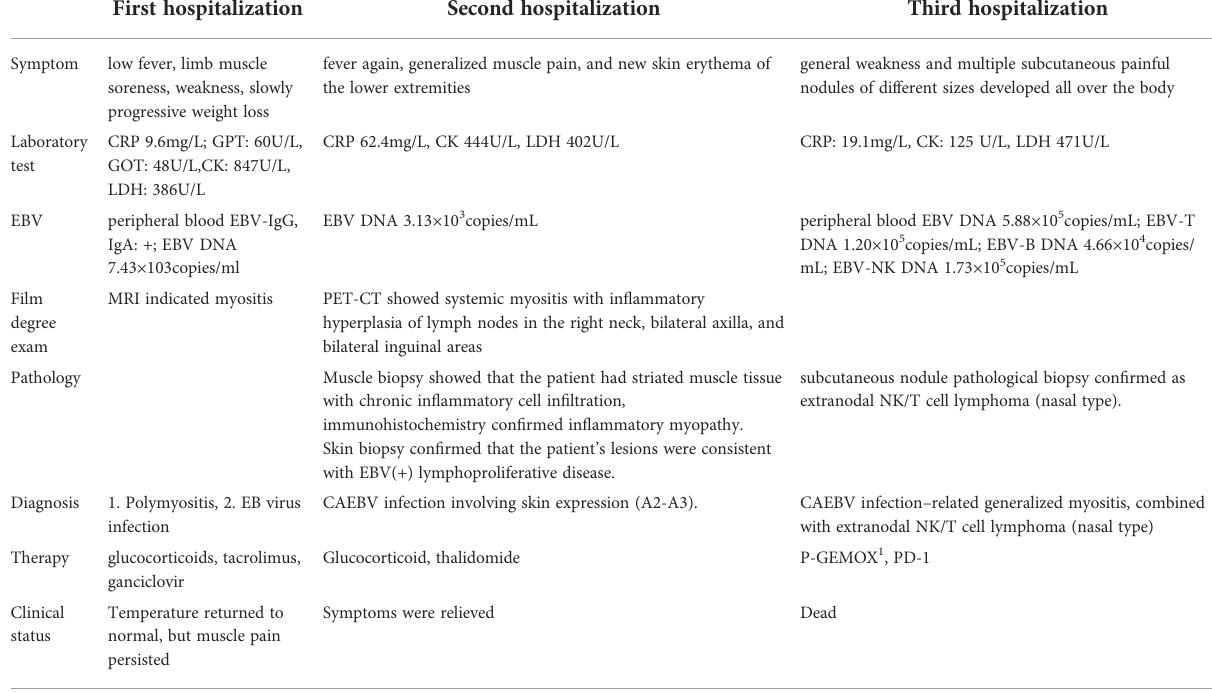
TABLE 1 The clinical characteristics and treatment of patients with three